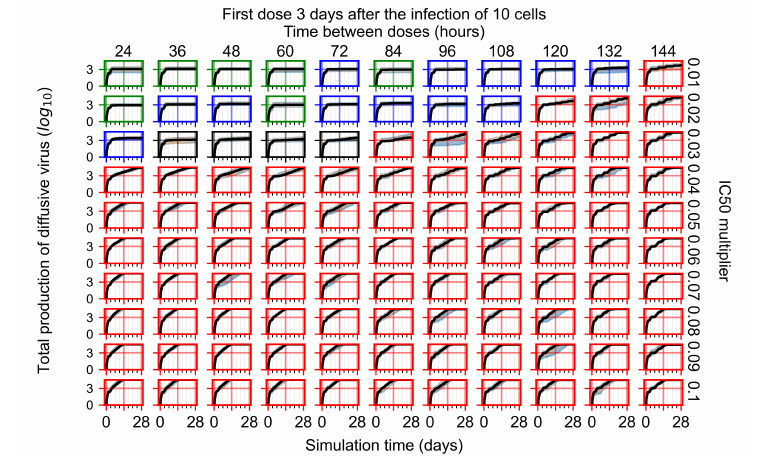
Figure A62. Total diffusive virus produced (AUC), Y axis in log scale, and exponent values as tick marks.